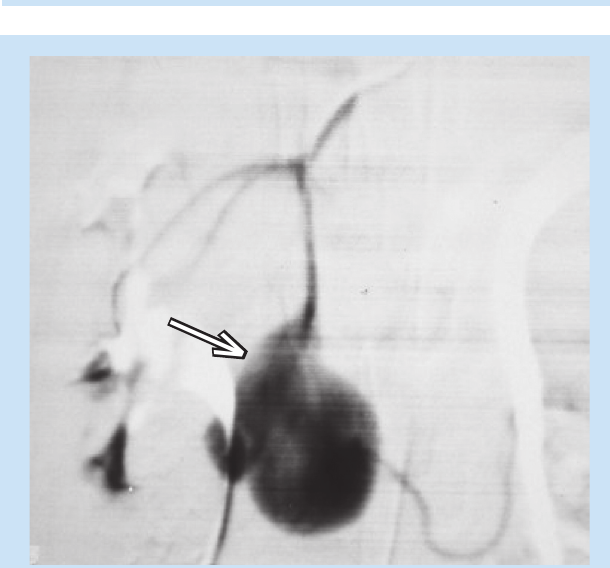
Fig. 3. CT scan performed 2 weeks after embolisation, revealing complete exclusion of the pseudoaneurysm (arrow).